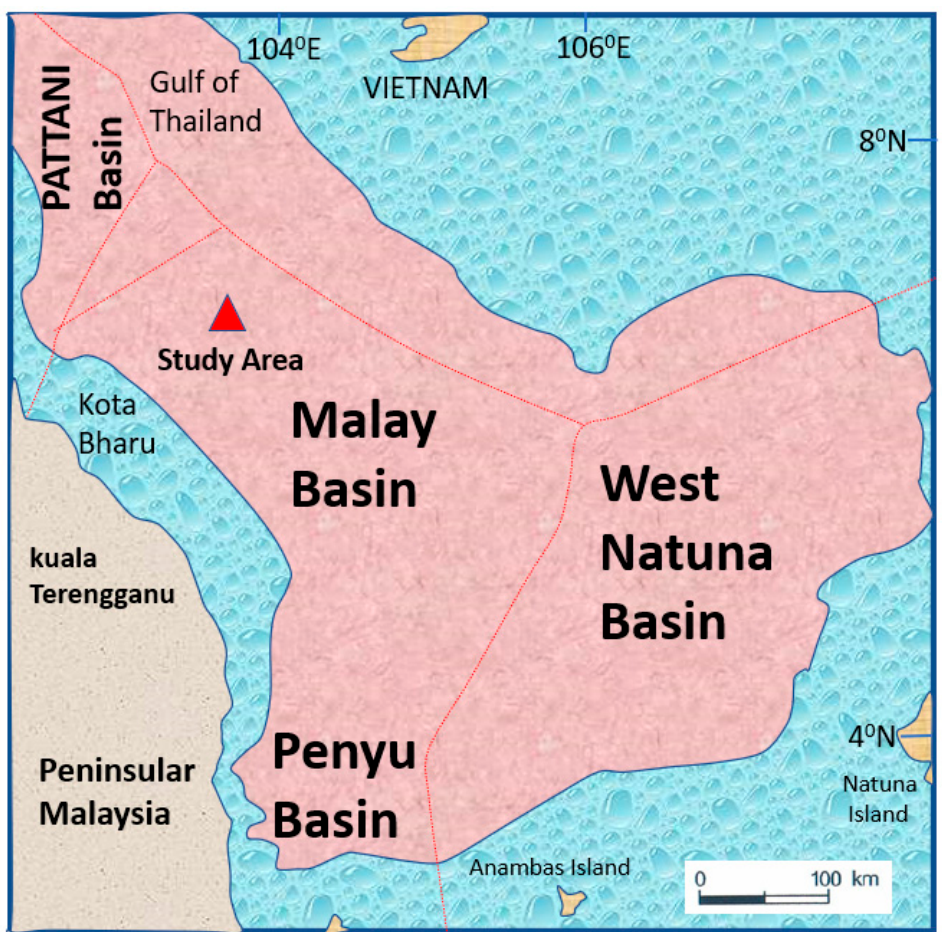
Figure 2. Location map of Malay and other bounding basins (modified after [38]).